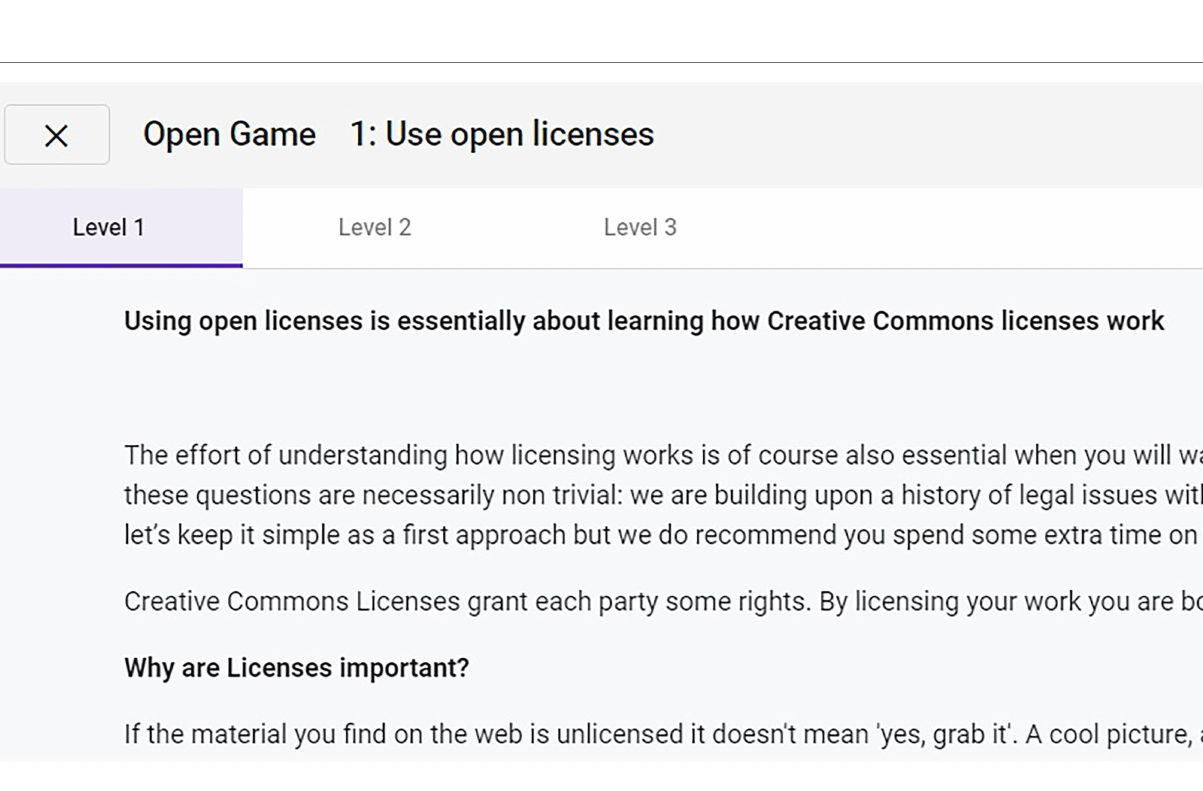
FIGURE 7 | Information of the unit of learning, with the different levels in different